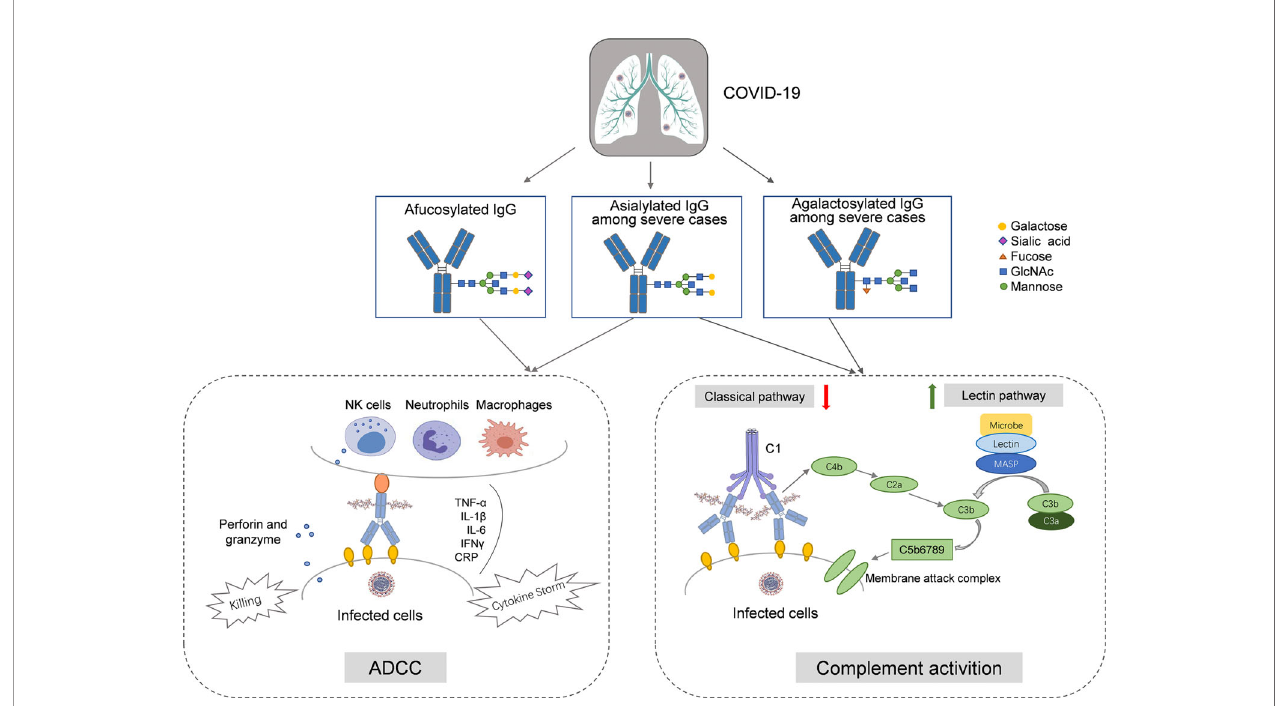
FIGURE 5 | The hypothesized roles of IgG N -glycosylation in the immunopathology of COVID-19. In COVID-19 cases, afucosylation of IgG Fc segment activates the antibody-dependent cell mediated cytotoxicity (ADCC) by ligating to Fc g RIIIa on natural killer (NK) cells, macrophage, and neutrophil, and then upregulates the release of proin fl ammatory factors ( e.g. , IL-1 b , IL-6, CRP, TNF- a , and IFN- g ). Among severe cases, agalactosylation and asialylation of IgG upregulates the activation of the lectin-initiated complement pathway, underlying the complex clinical phenotypes during SARS-CoV-2